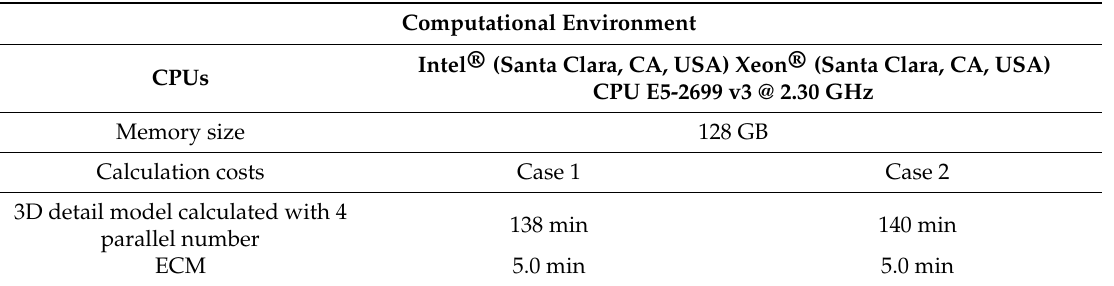
Table 3. Computational environment and calculation costs of our